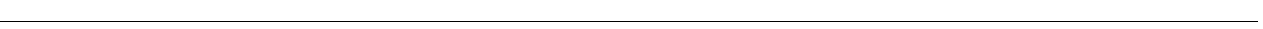
(Fig. 5b – d; compare red to the blue or the green peri-stimulus time histograms (PSTHs); Supplementary Tables 6 and 7).